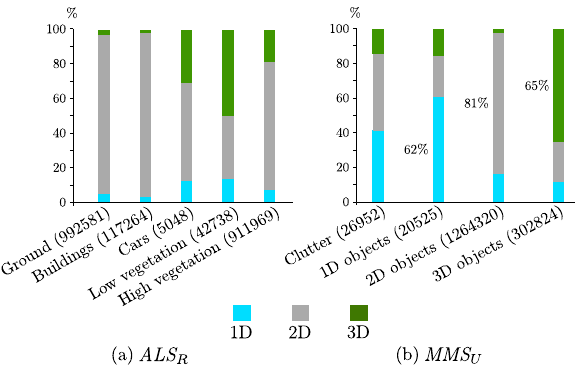
Figure 6: dimensionality labelling statistics for two datasets available with ground truth. (a) ALS G dataset: the five main classes have been conserved. (b) MMS U dataset: the 59 classes have been condensed into four classes according to their shape (1D: wires, poles, trunks etc. – 2D: wall, door, facade etc. – 3D: foliage, grass etc. – Clutter: objects without specific shapes). The number of points for each class is indicated inside brackets.